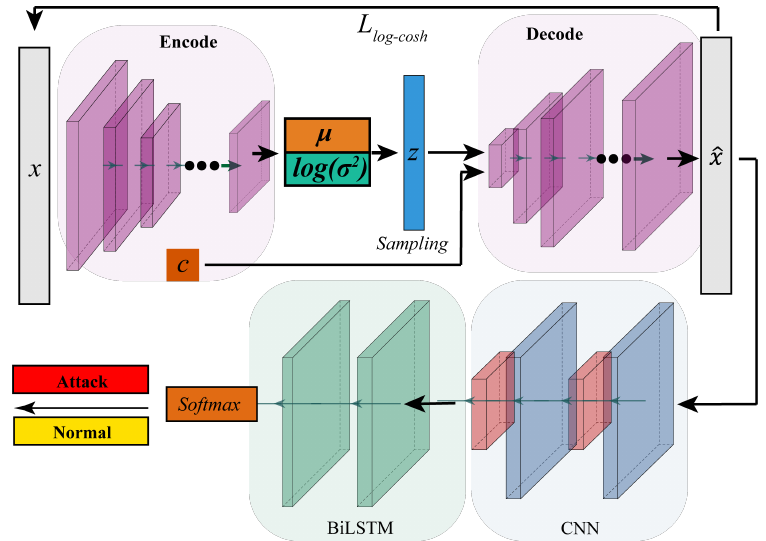
Figure 1. Overall framework of the